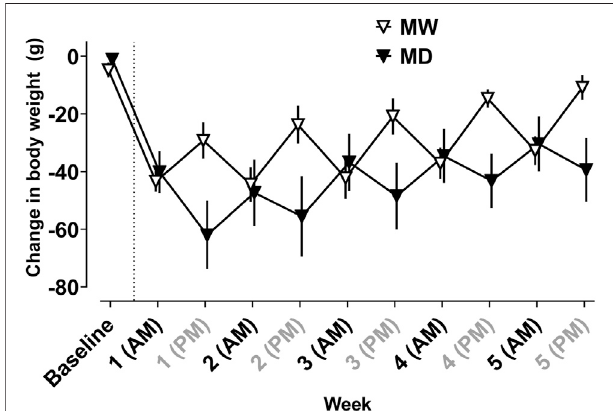
FIGURE 1 | Average change in body weight (g) from baseline weight measured every 12 h in the 12 h (MD) and 20 h (MW) deprivation groups. The dotted line represents induction of dependence. All self-administration sessions occurred at AM time points. The MW group received morphine at AM time points and the MD group received morphine at PM time points. Data represent the mean ( ± SEM), and each point represents six to eight